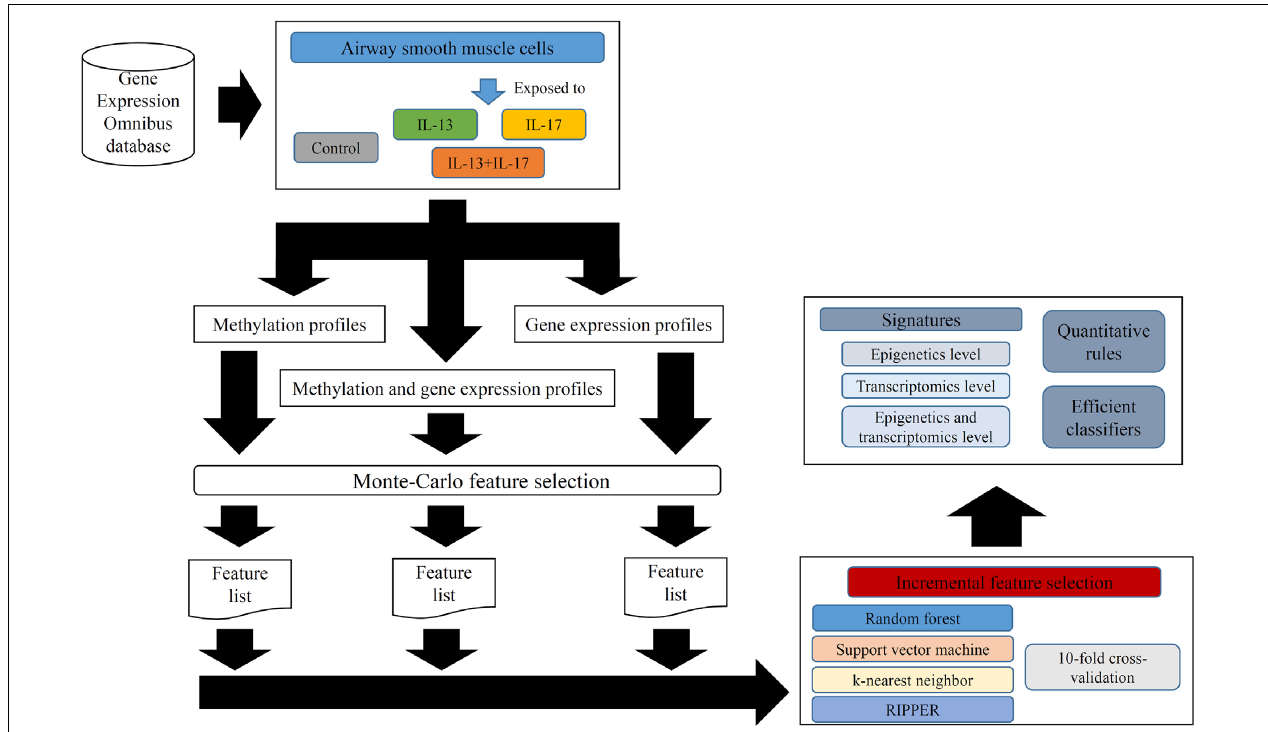
FIGURE 1 | Entire procedures for analyzing methylation and gene expression profiles of airway smooth muscle cells (ASMCs). The methylation and gene expression profiles of ASMCs are retrieved from Gene Expression Omnibus database. The cells are classified into four categories (control, IL-13, IL-17, and IL-13 + IL-17). Three datasets with different combination of profiles are constructed. Each dataset is first analyzed by Monte Carlo feature selection method, producing a feature list. The list is fed into the incremental feature selection method, incorporating one of the four classification algorithms. The results includes: (1) essential signatures from different levels; (2) quantitative rules; (3) efficient classifiers.